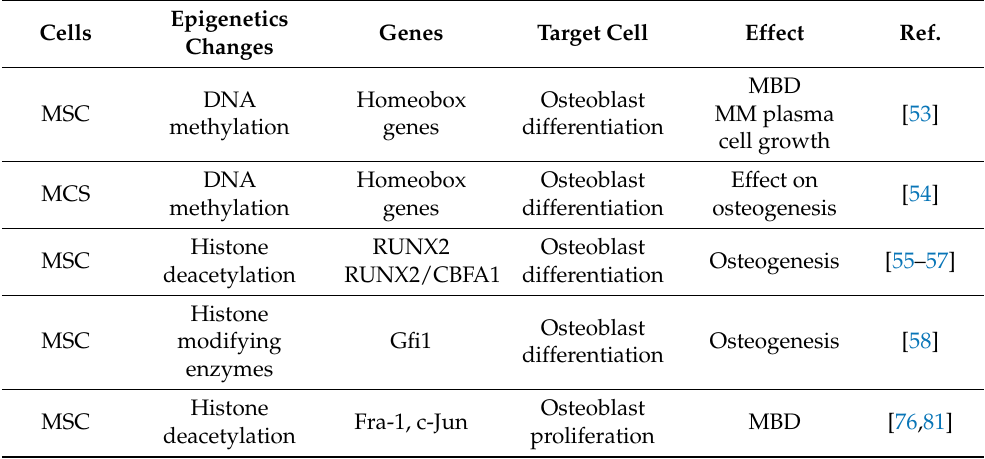
Table 1. Effects of epigenetic changes in the bone marrow microenvironment on MM progression and